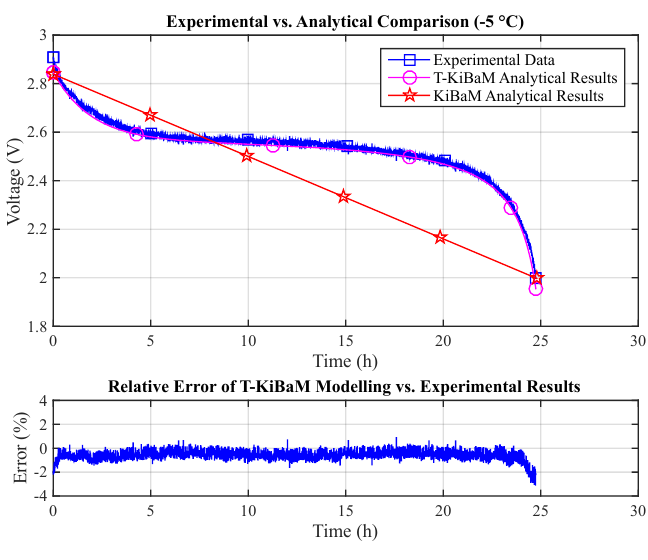
Relative Error of T-KiBaM Modelling vs. Experimental Results